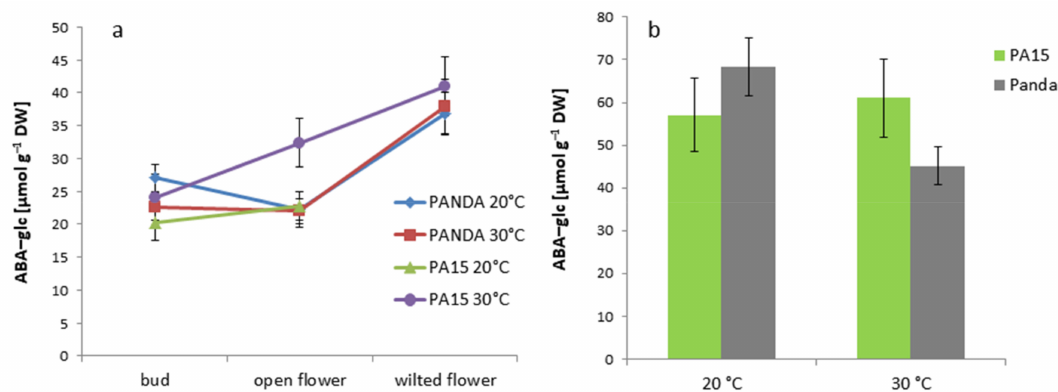
Figure 10. Content of ABA-glc [ µ mol g − 1 DW] in the flower buds, open flowers, and wilted flowers ( a ) and the leaves ( b ) of the ‘Panda’ and PA15 plants grown at 20 ◦ C (control) and 30 ◦ C (thermal stress). Means ( n = 3) ± SE.